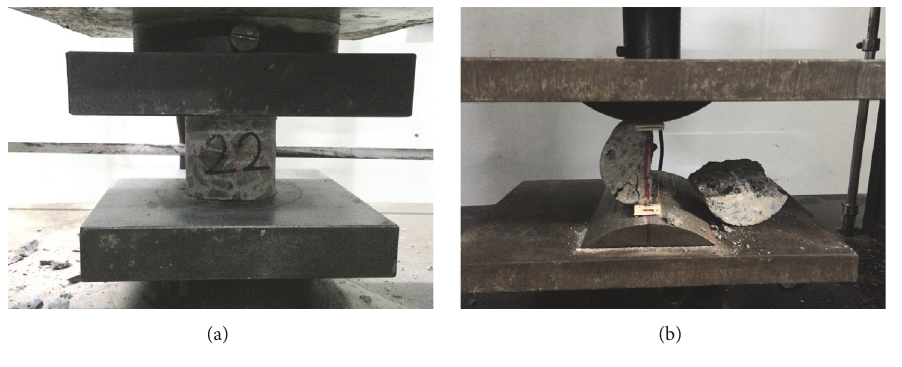
Figure 4: Loading